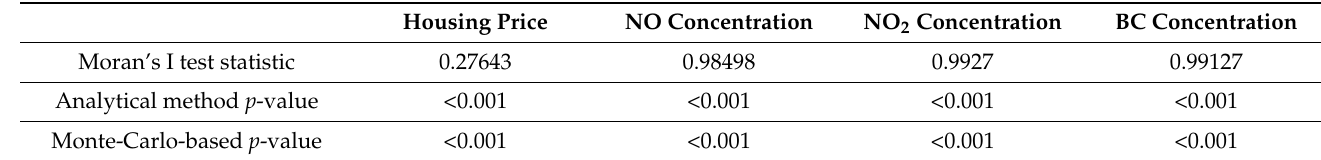
Table 2. Moran’s I test results for housing prices and three